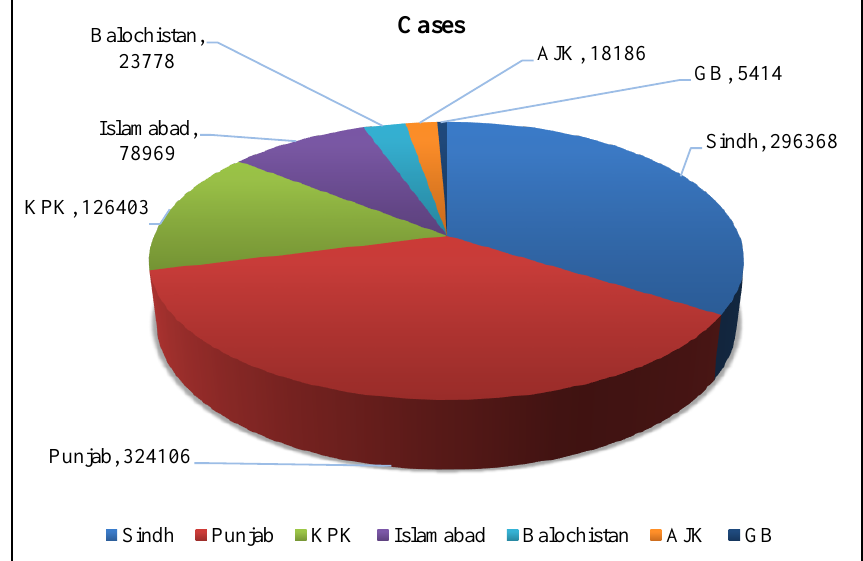
Figure 1. Province Wise COVID-19